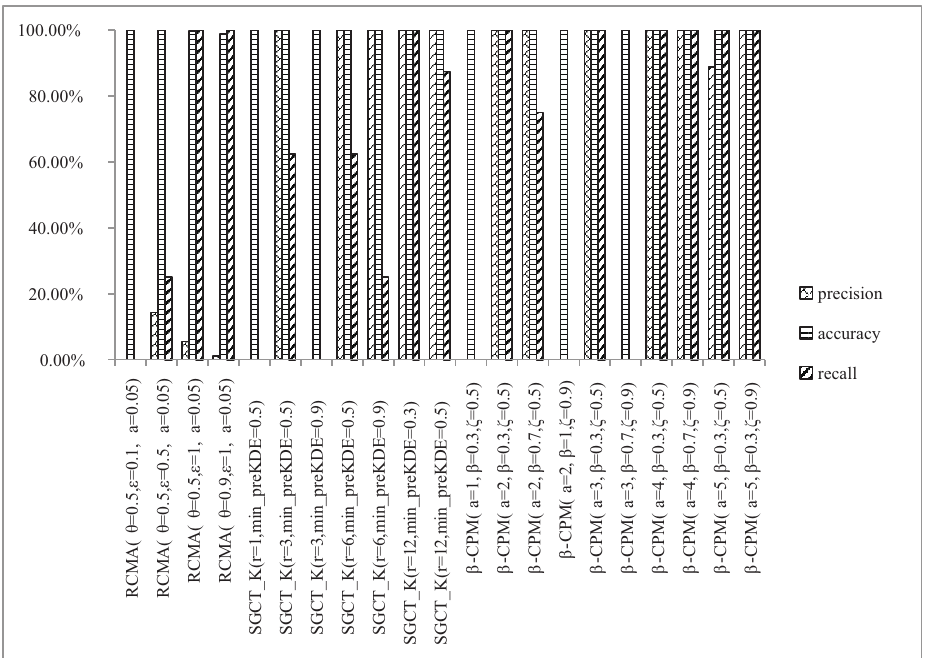
Figure 5. The precision, accuracy, and recall of different algorithms with some parameters on the Synthetic data set. The tests are based on β -CPM in comparison with RCMA and